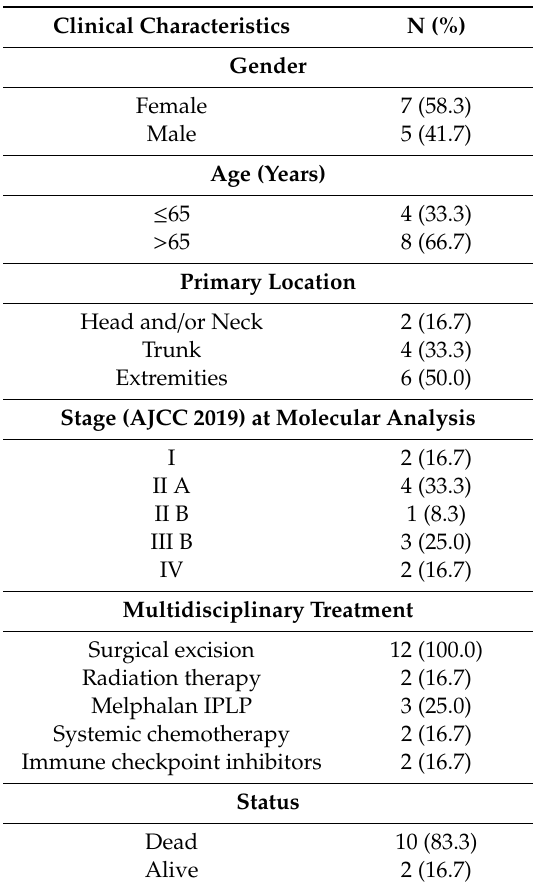
Table 1. Clinical characteristics of Merkel cell carcinoma (MCC)